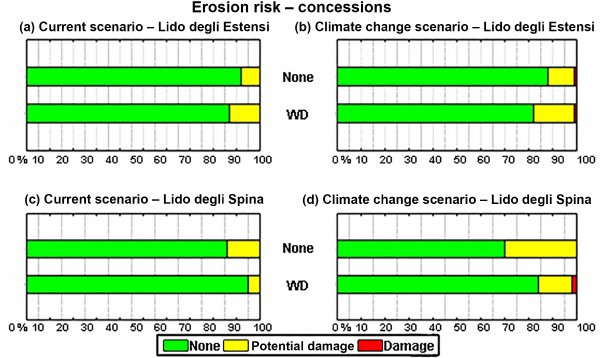
Figure 15. Distribution of concessions for every level of erosion risk. (a) Current scenario at Lido degli Estensi; (b) climate change scenario at Lido degli Estensi; (c) current scenario at Lido di Spina; (d) climate change scenario at Lido di Spina. Each bar in a panel represents a risk reduction configuration (“none”: no risk reduction implemented; “WD”: winter dune; “FRM”: flood resilience mea-